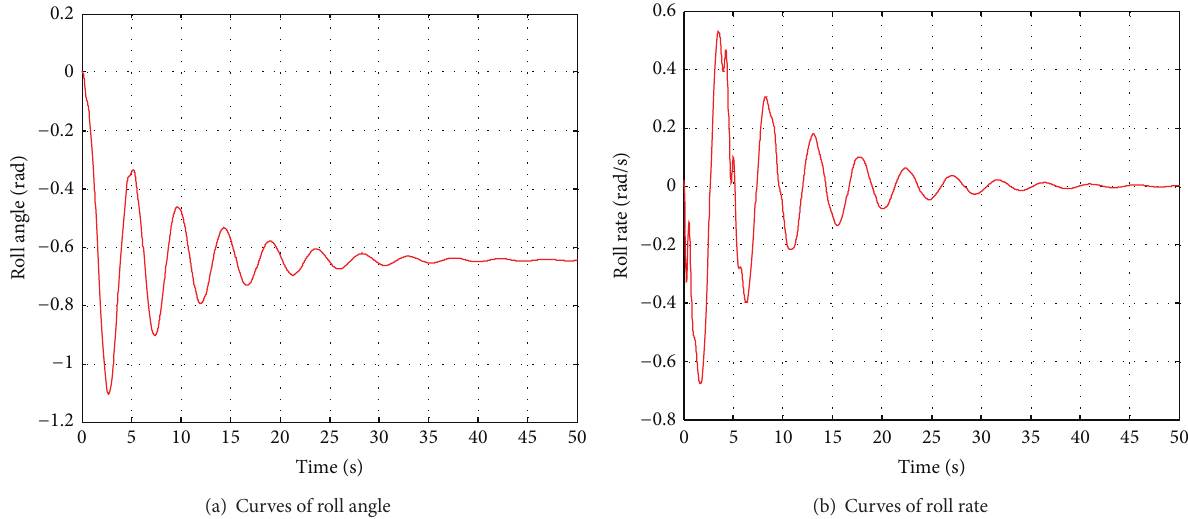
Figure 13: Tank truck driving stability when liquid fill level is 0.8.